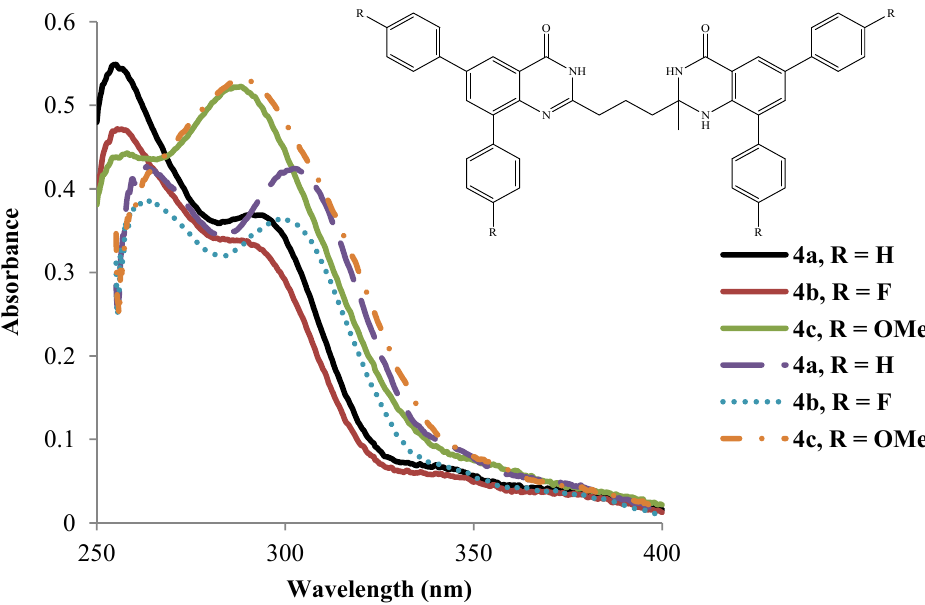
Figure 2. UV-Vis spectra of 4a – c in DMSO (dashed lines) and CH (conc. = 1.0 × 10 − 5 mol/L).